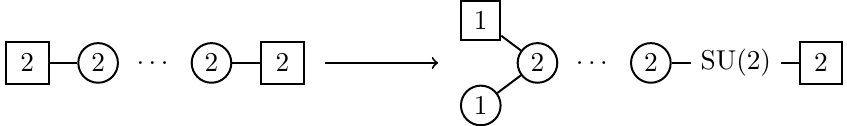
Figure 7. The N = 4 duality we use to construct the mirror dual of U(2) adjoint SQCD. There are k (cid:0) 1 U(2) gauge groups on the left and k (cid:0) 2 on the